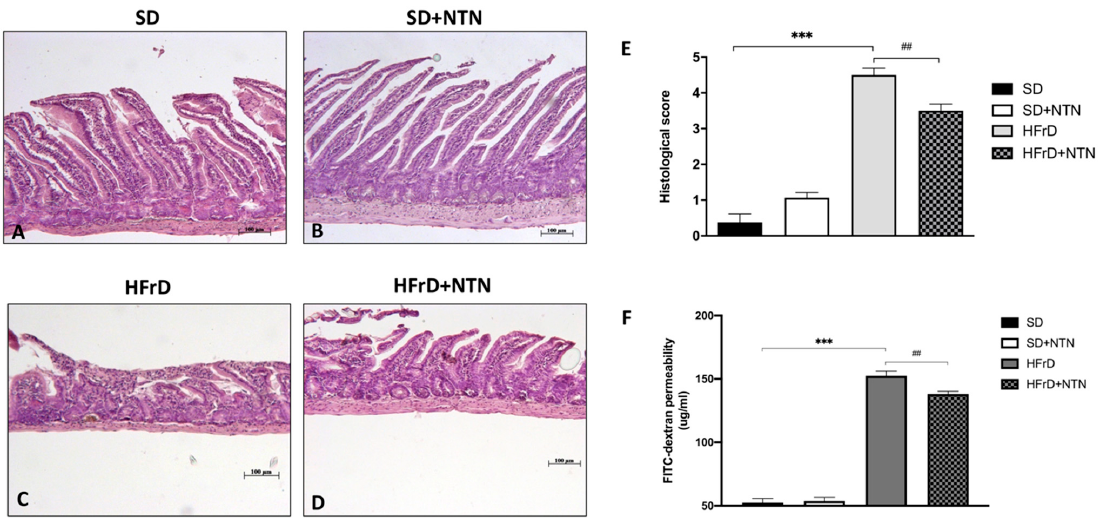
Figure 10. Effects of NTN on intestinal features in HFrD mice. Significant infiltration of inflammatory cells and tissue damage was observed in mice fed with HFrD ( C , E ) compared to SD and SD + NTN mice ( A , B , E ). Administration of NTN was able to significantly counteract the extent of intestinal tissue damage ( D , E ). A gut permeability assay exhibited an evident increase of intestinal permeability in HFrD jejunum compared to the SD group ( F ); NTN showed protective properties decreasing gut permeability ( F ). Data are representative of at least three independent experiments. Values are means ± SEM. One-Way ANOVA test. *** p < 0.001 vs. SD; ## p < 0.01 vs. HFrD. 3.10. Effect of NTN on Epithelial Integrity in the Intestines of HFrD Mice